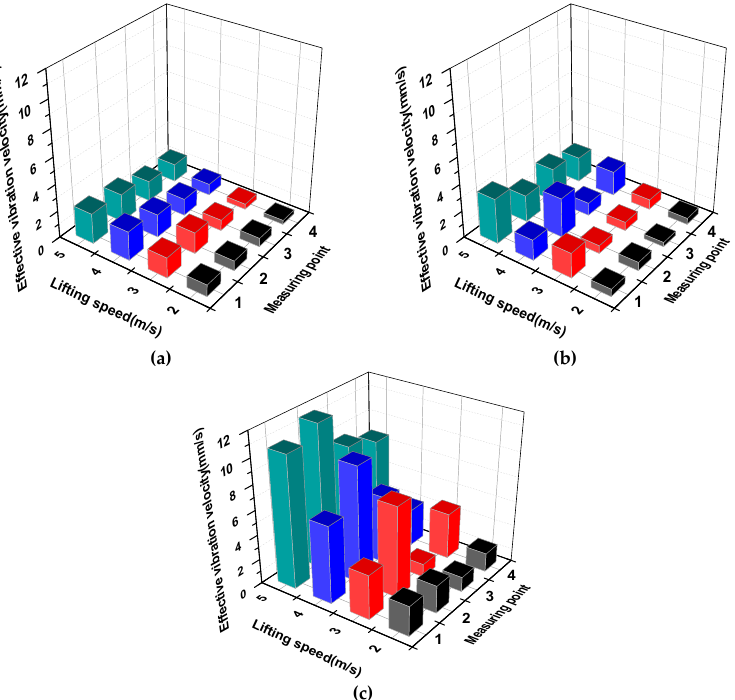
Figure 8. Effective vibration velocity of the rope in different directions. ( a ) Long side direction, axis Figure 8. E ff ective vibration velocity of the rope in di ff erent directions. ( a ) Long side direction, axis X; X; ( b )Vertical direction, axis Y; ( c ) Short side direction, axis Z. ( b ) Vertical direction, axis Y; ( c ) Short side direction, axis